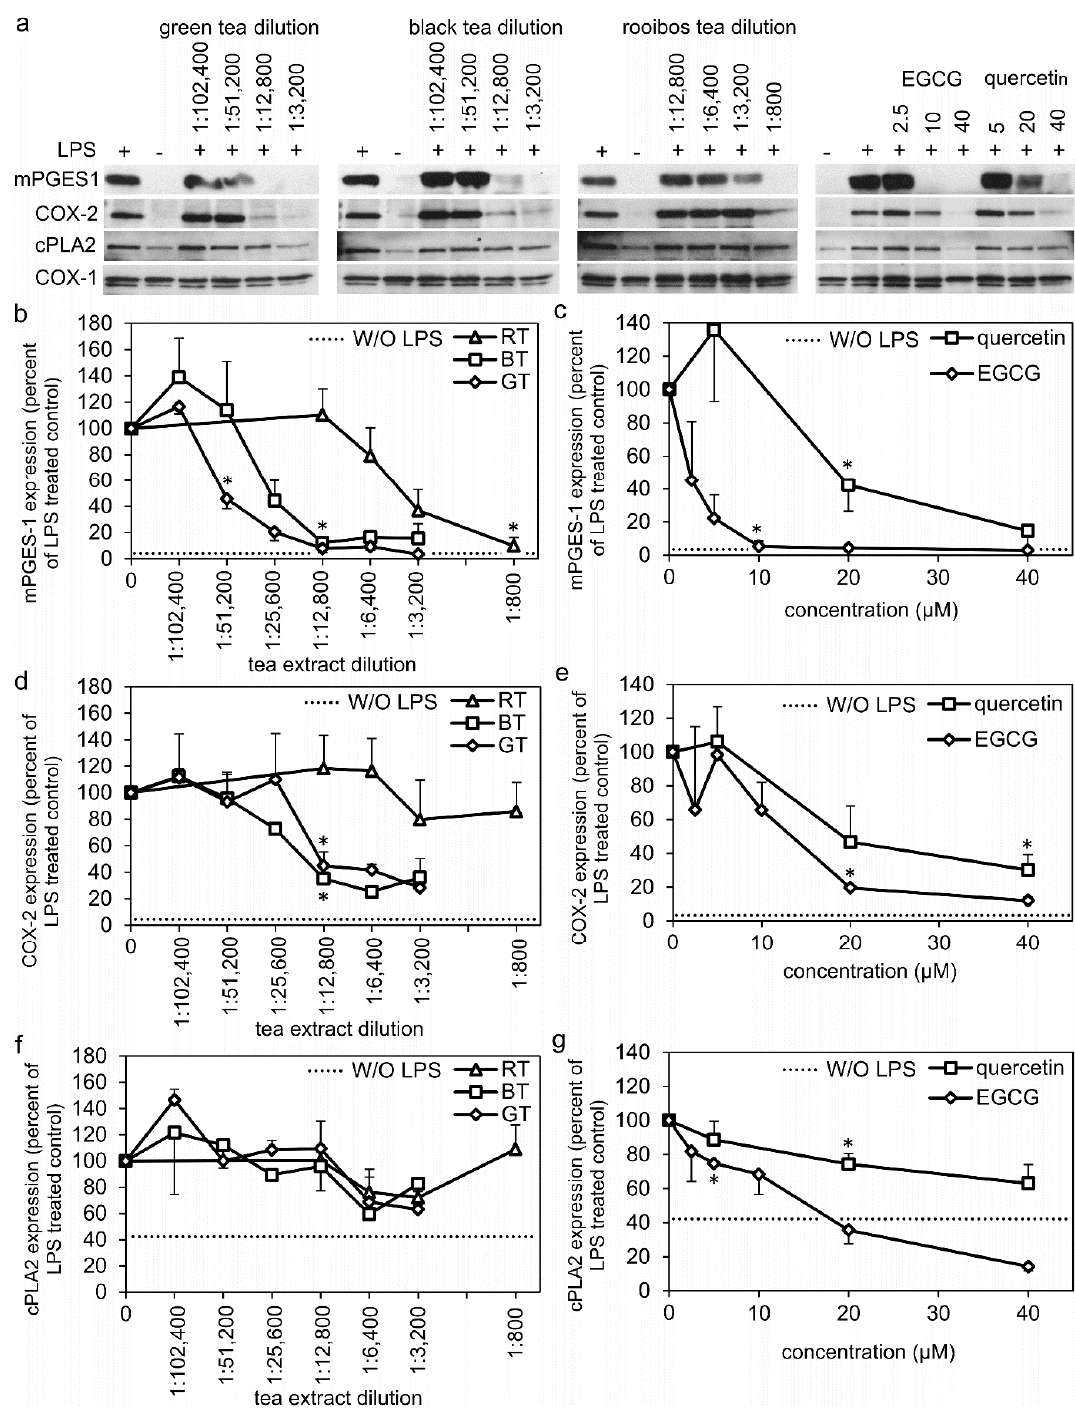
Figure 2. ( a ) Representative Western blots of mPGES-1, COX-1, COX-2, and cPLA2 expression in human monocytes after indicated treatments for 24 h. ( b – g ) Densitometric quantification of Western blot results compared to LPS treatment alone. COX-1 expression was used as the internal loading control. Results for each individual data point represent mean value ± SEM of 1–5 independent experiments with human monocytes from different preparations. Dotted lines ( b – g ) indicate the basal expression (without LPS treatment) of each protein. BT: black tea extract, GT: green tea extract, RT: Rooibos tea extract, EGCG: epigallocatechin gallate. * denotes the highest dilution/lowest concentration mediating a significant inhibition ( p < 0.05). Uncropped versions of the Western blots are shown in Supplementary Materials, Figure